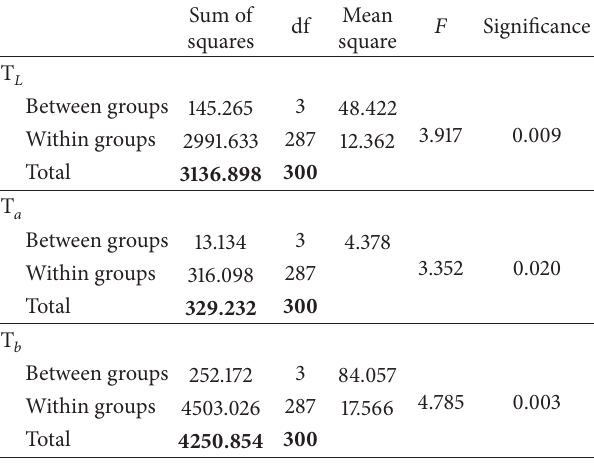
Table 2: One-way ANOVA analysis for tooth 𝐿,𝑎 , and 𝑏 values.